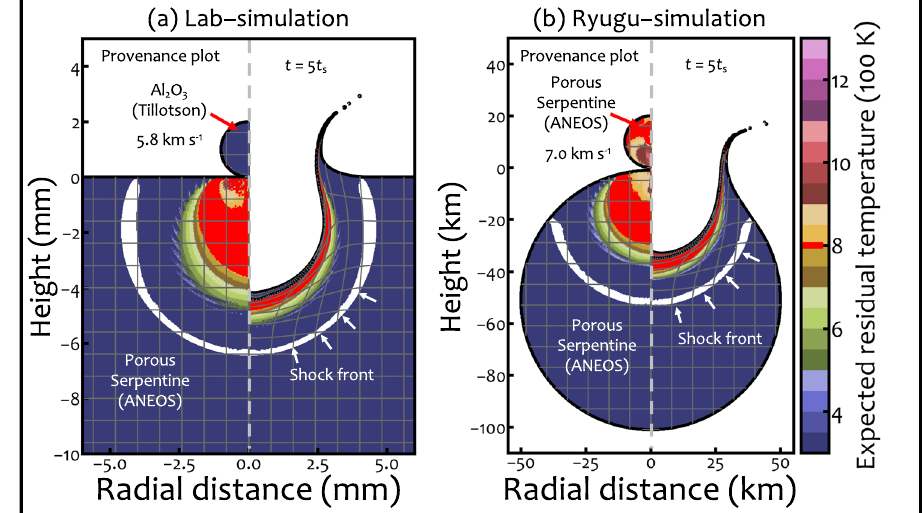
Fig. 3 Numerical results. a The result of the Lab-simulation at the high v imp obtained with the iSALE shock physics code. A snap shot (right) and provenance plot (left) are shown. The colour indicates the expected residual temperature T res calculated from the temporal entropy. A grid of tracer probes, plotted every 25 cells in the horizontal and vertical directions, is shown as grey lines. The location of the shock front is shown in a white line. Note that we did not calculate T res in the Al 2 O 3 projectile. b The same as ( a ), except the result of the Ryugu-simulation is shown. In this calculation, the impact velocity was set to 7 km s – 1 . In these panels, the results are shown for t = 5 t s ( t is the time after impact), where t s = D p / v imp and is the characteristic time for projectile penetration, and D p is the projectile diameter. This time was chosen because at this point the impact heating is fi nished.